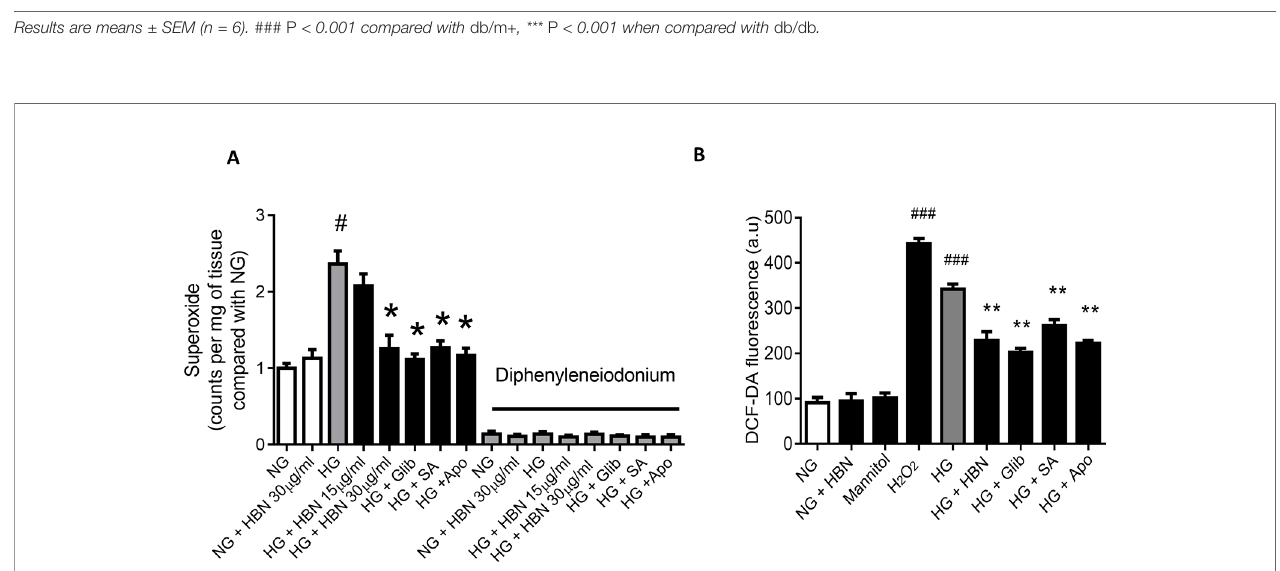
Results are means ± SEM (n = 6). ### P < 0.001 compared with db/m+ , *** P < 0.001 when compared with db/db .